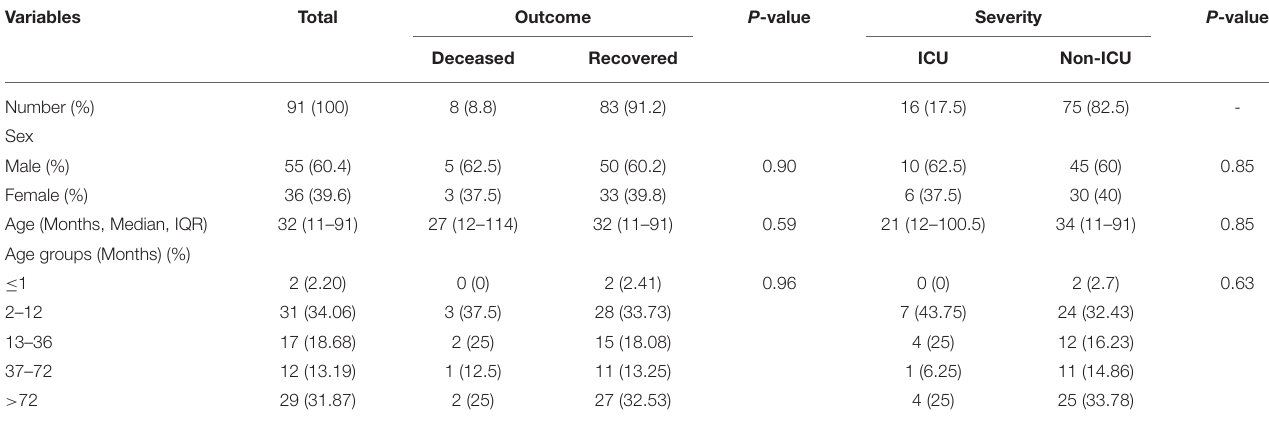
TABLE 1 | Demographic data of pediatric COVID-19